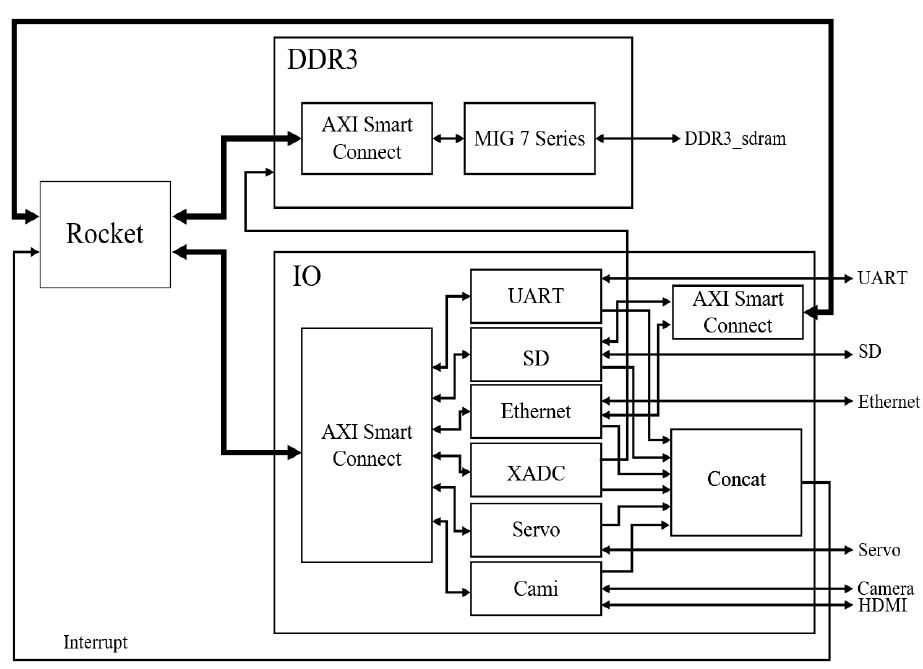
Figure 3. Module